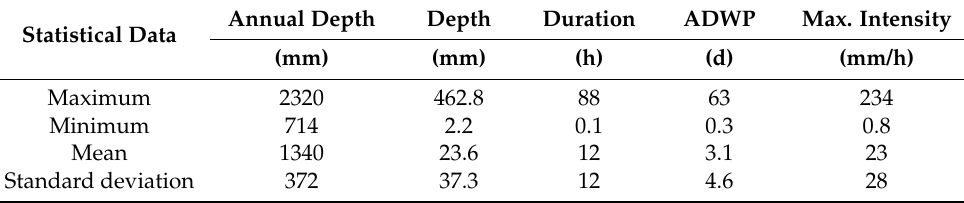
Table 2. Rainfall characteristics for the time series climate records (1990–2015) of Villa Cambiaso (Genoa, Italy). ADWP is the antecedent dry weather period and the maximum intensity is evaluated over 10